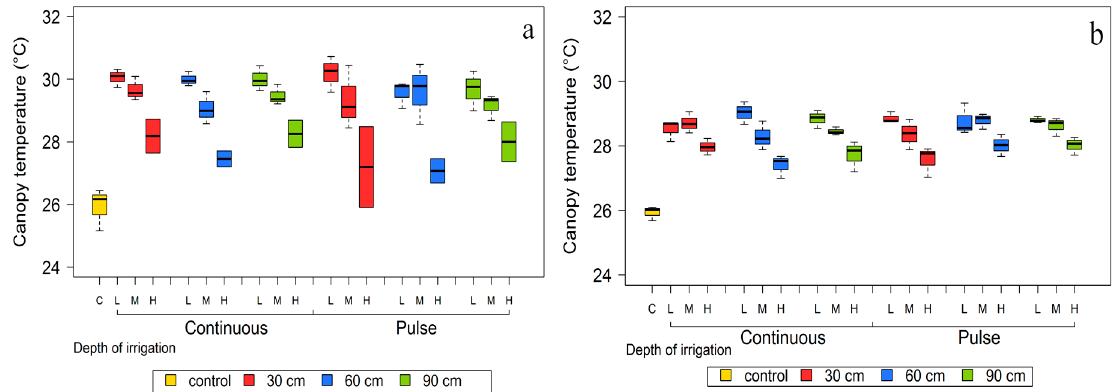
Figure 10. Canopy temperature data obtained at ( a ) 80 and ( b ) 44 DBH. In the boxplot, the upper and lower whiskers represent the maximum and minimum values, the upper and lower box borders represent the 75th and 25th percentile values, respectively, and the horizontal dark line indicates the median. C = control, 100% standard irrigation rate; L = low level of irrigation, 15%; M = medium level of irrigation, 30%; H = high level of irrigation, 60%.